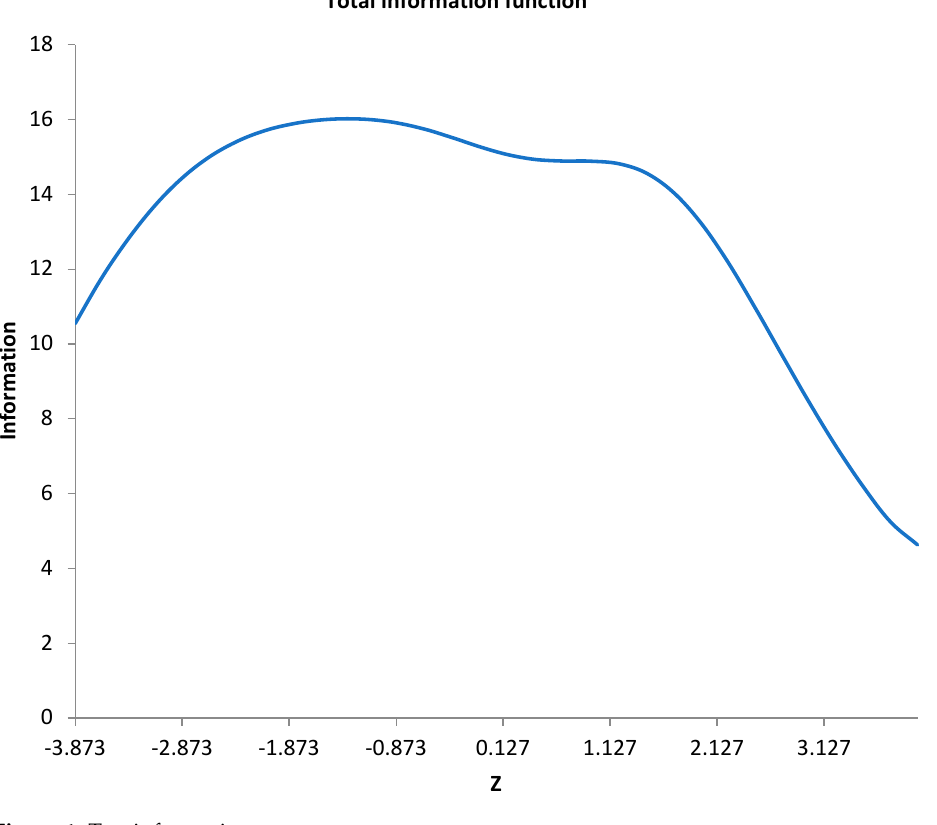
Figure 1. Test information curve.